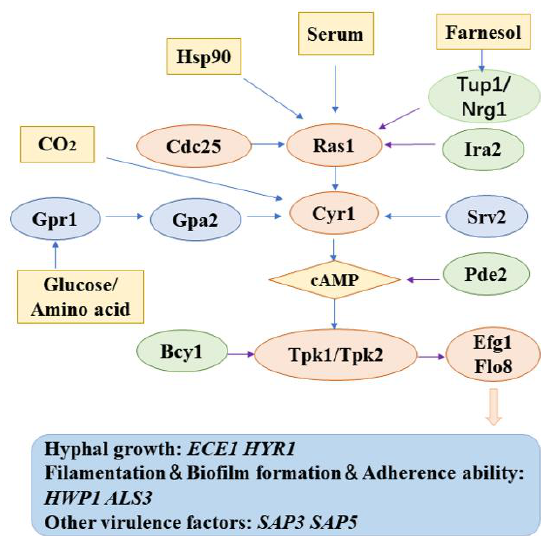
Figure 9. Schematic diagram of Ras/cAMP/PKA pathway in C. albicans (blue arrow represents activation and purple arrow represents inhibition).